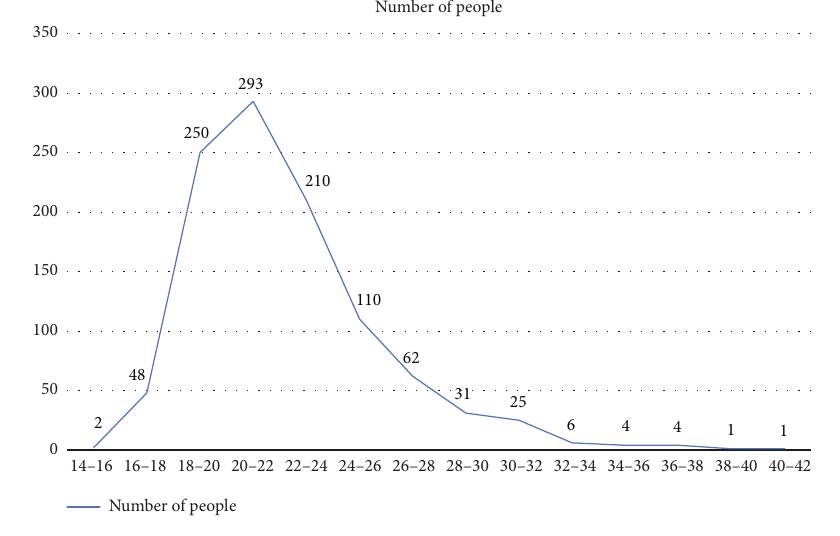
Figure 4: Histogram of the distribution of students ’ body mass index BMI.